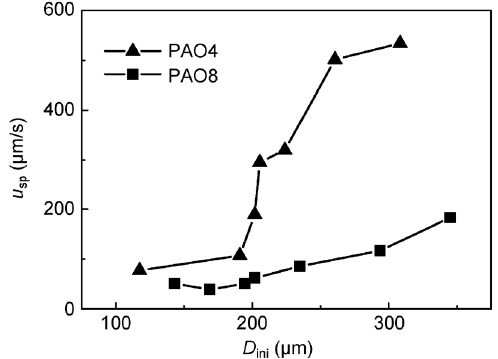
Fig. 7 Influence of viscosity on spreading velocity, w = 30 N, D ini = 220 μ